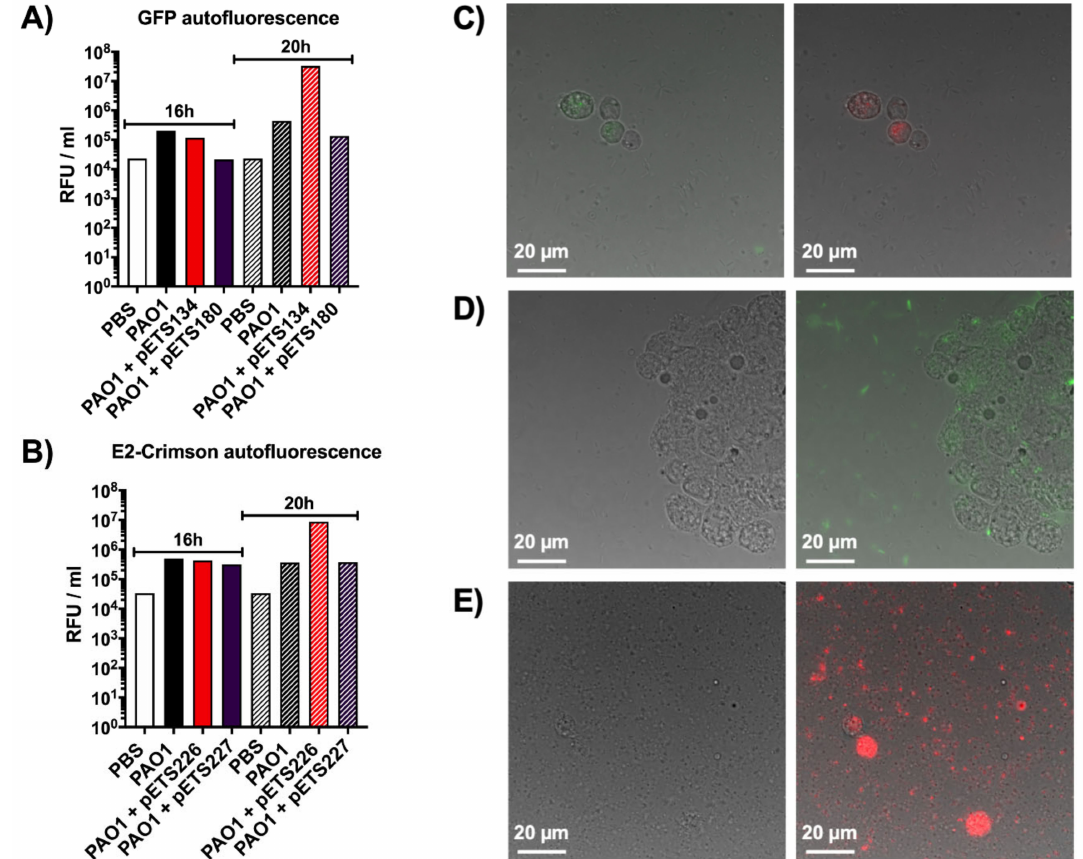
Figure 2. Autofluorescence studies in the hemolymph of G. mellonella . ( A ) Quantification of green autofluorescence, in relative fluorescence units per milliliter of hemolymph, using larvae infected with di ff erent P. aeruginosa strains and PBS (negative control) at 16 and 20 h post-infection. ( B ) Quantification of red autofluorescence, in relative fluorescence units per milliliter of hemolymph, using larvae infected with di ff erent P. aeruginosa strains and PBS (negative control) at 16 and 20 h post-infection. ( C ) Phase contrast merged with green and red fluorescence images of hemolymph extracted from larvae infected with P. aeruginosa PAO1 wild-type showing the green and red autofluorescence of hemocytes, respectively. ( D ) Phase contrast only and phase contrast merged with green fluorescence images of hemolymph extracted from larvae infected with P. aeruginosa PAO1 P nrdA -GFP. ( E ) Phase contrast only and phase contrast merged with red fluorescence images of hemolymph extracted from larvae infected with P. aeruginosa PAO1 P nrdA